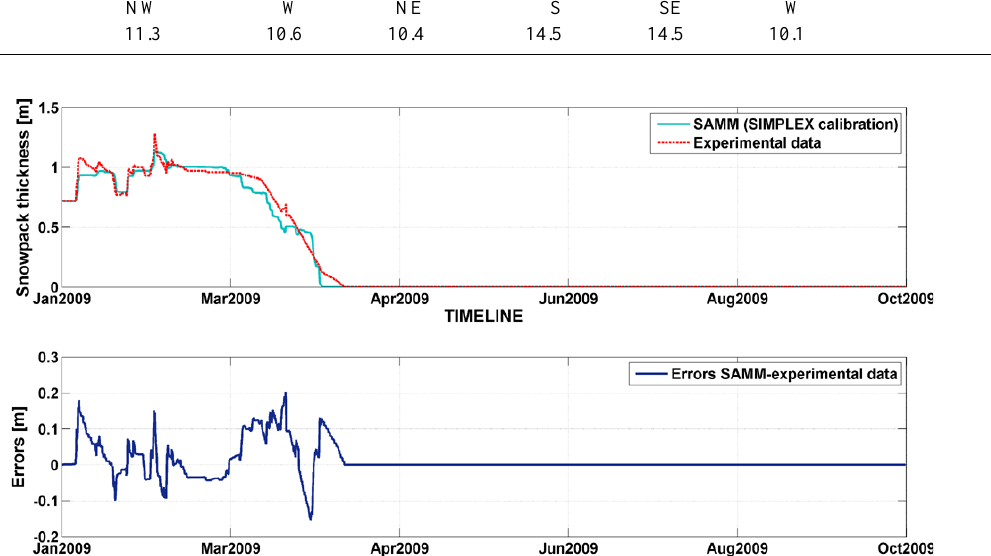
Fig. 3. Calibration of the model with the event January 2009–March 2009 registered by the Doccia di Fiumalbo station, using simplex flexible